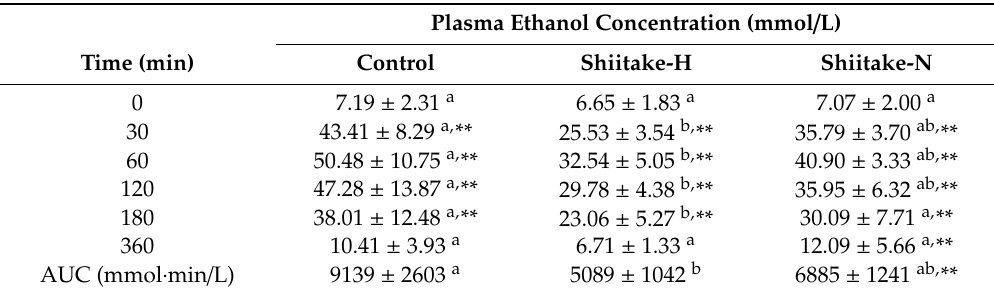
Table 1. Effect of shiitake extract on plasma ethanol concentration after oral administration of ethanol.